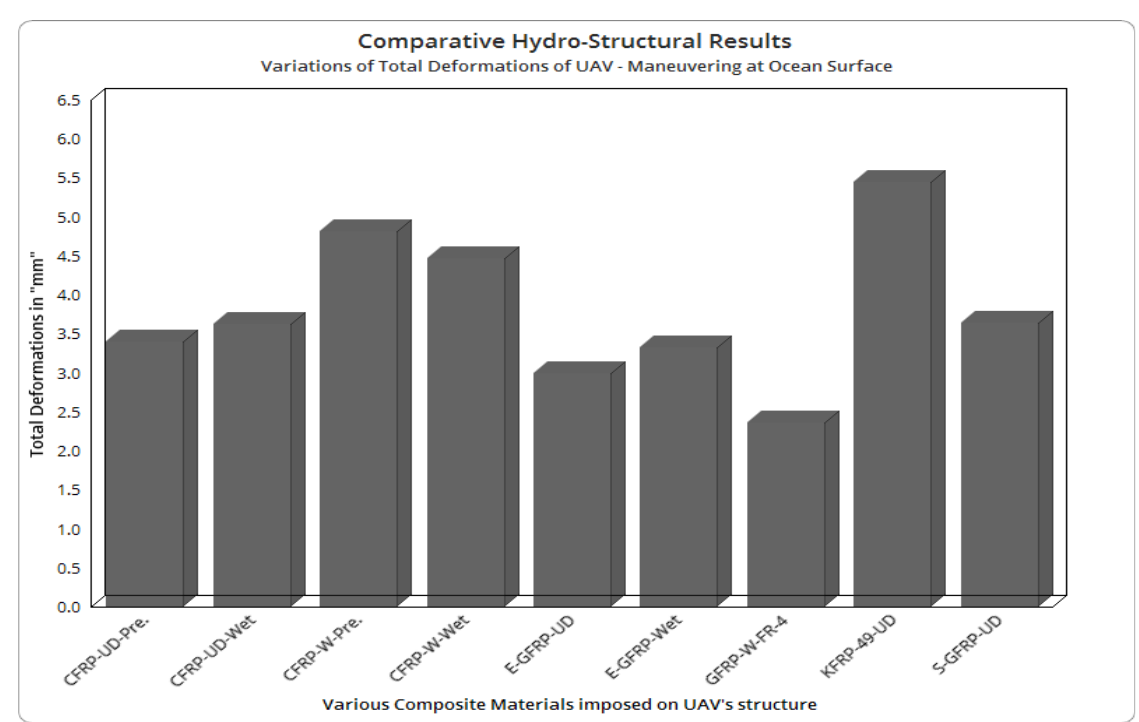
Figure 28. Variations of total deformations of different composite materials.